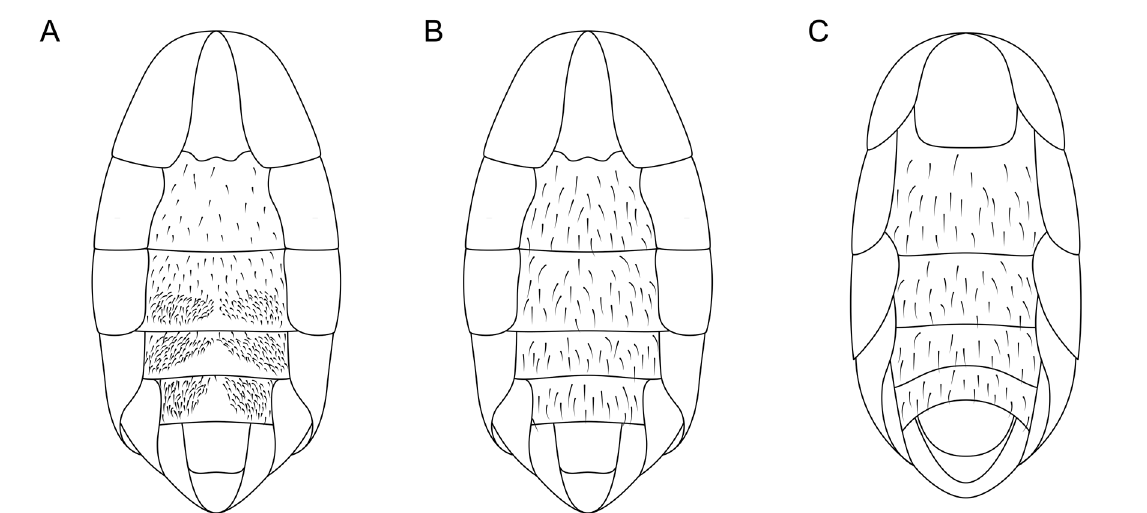
Fig. 116. Metasomal sterna, ♂. A . Lasioglossum ( D. ) zephyrus (Smith, 1853), with hair concentrated in apicolateral areas of S3–5. B . Typical red-tailed Lasioglossum ( Dialictus ), with hair evenly distributed and S5 straight. C . L. ( D. ) hudsoniellum (Cockerell, 1919), with S5 concave.